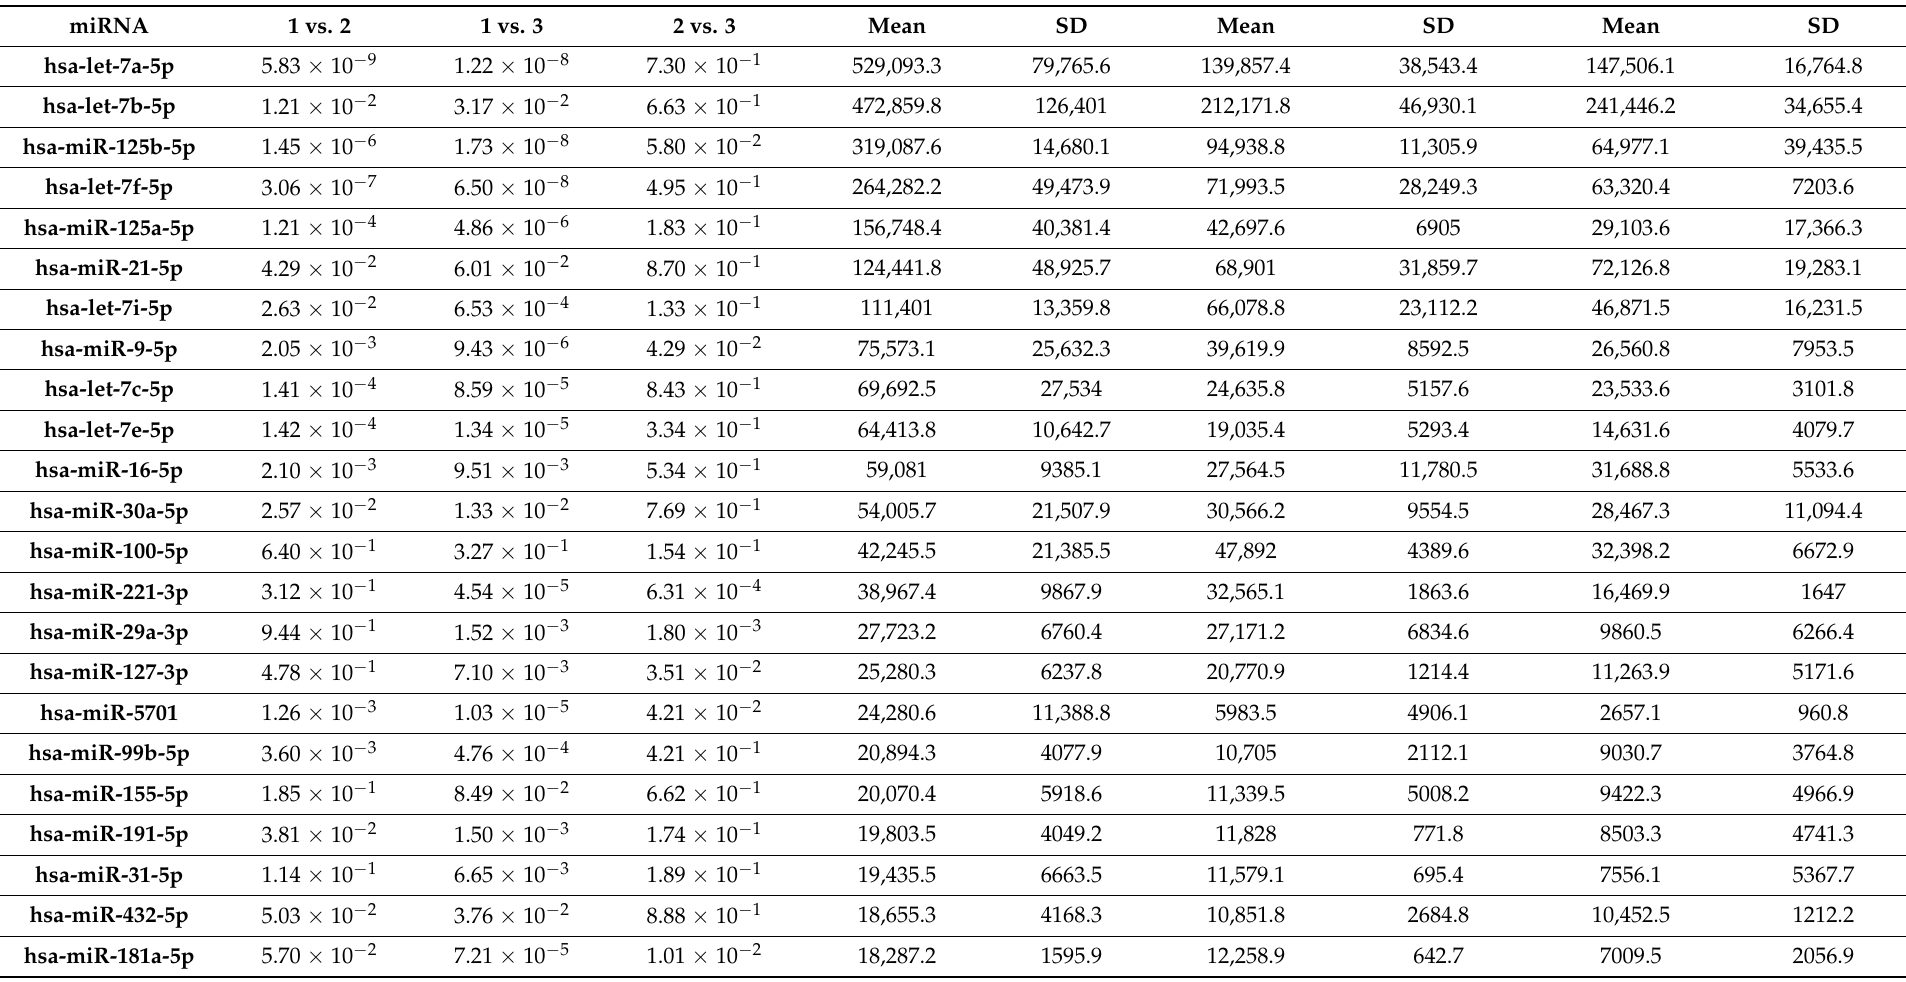
Table 2. The most abundant cellular miRNA identified (1 = cellular, 2 = EV-enriched, and 3 = EV lumen), shown as the mean and SD of three separate biological replicates. (The full table is shown as Supplementary Materials Table